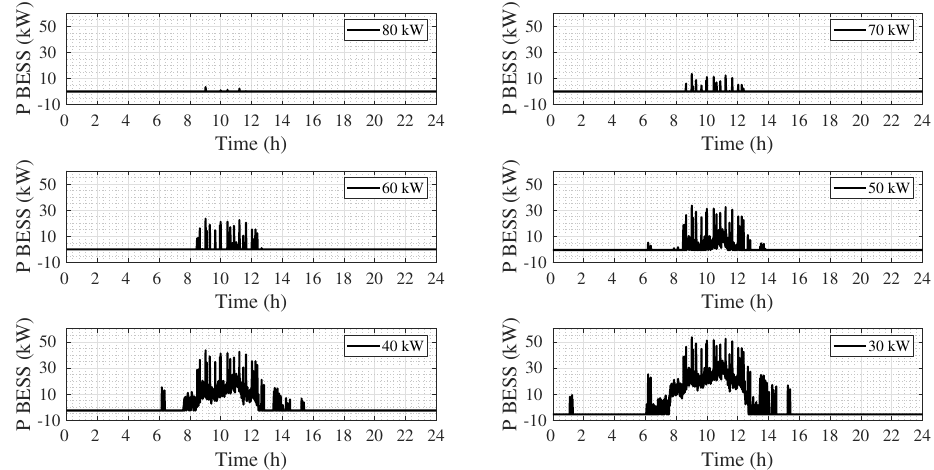
Figure 10. BESS power profile in winter for different values of P LIM